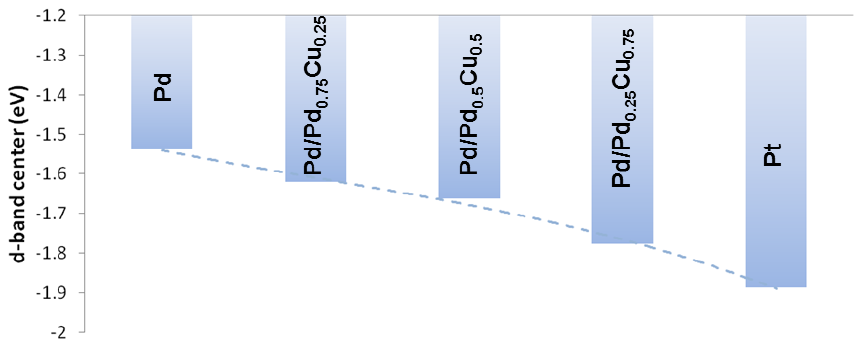
Figure 3. Changes in the position of Pd d-band center with respect to Fermi level on Pd Cu 1 − x x